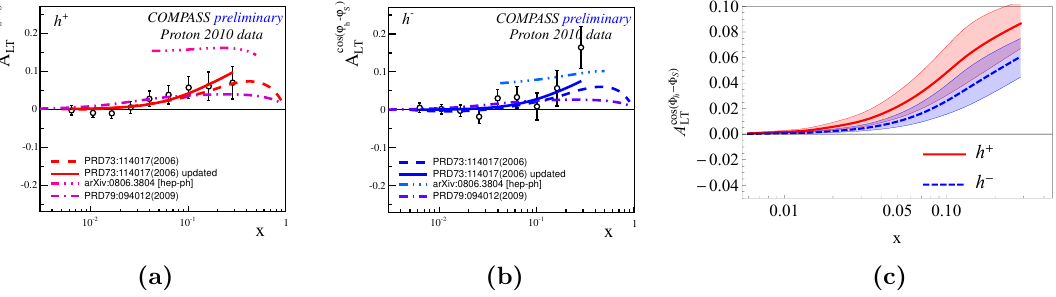
Figure 11. Leading-twist A cos( (cid:30) h (cid:0) (cid:30) S ) : preliminary COMPASS data [167] (a,b); and our calculation LT for COMPASS kinematics (c) shown separately for reasons explained in the caption of (cid:12)gure